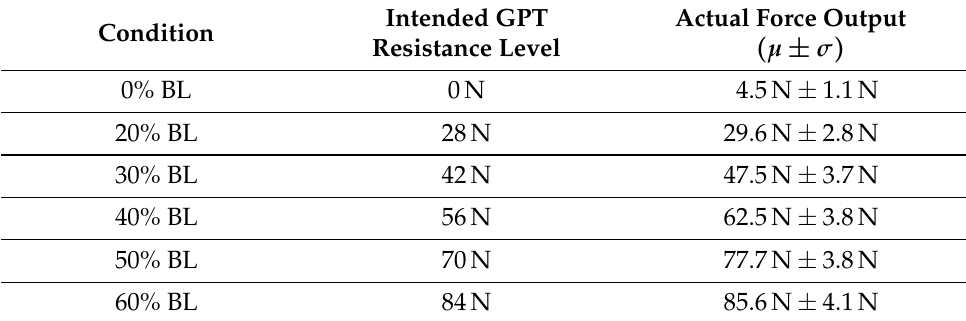
Table 3. Force magnitudes in the hardware verification test, BL =